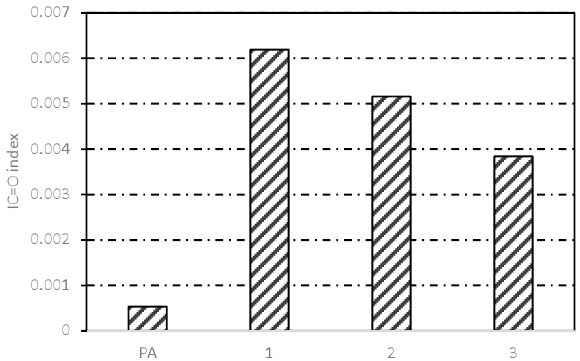
Figure 16. I C=O index of asphalt binder after induction heating in different layers.